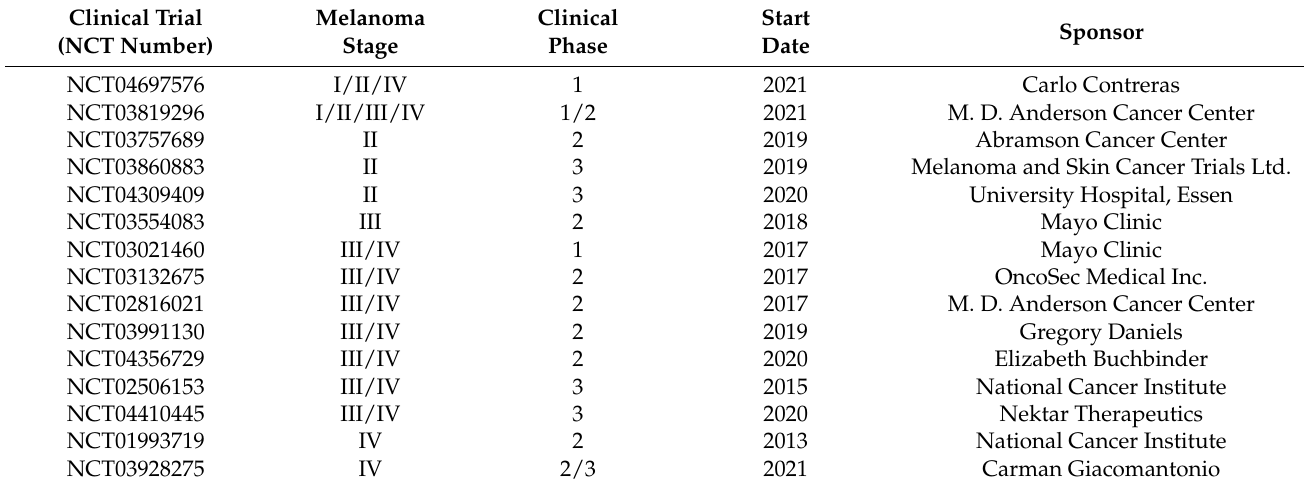
Table 5. Examples of ongoing clinical trials for each melanoma stage.